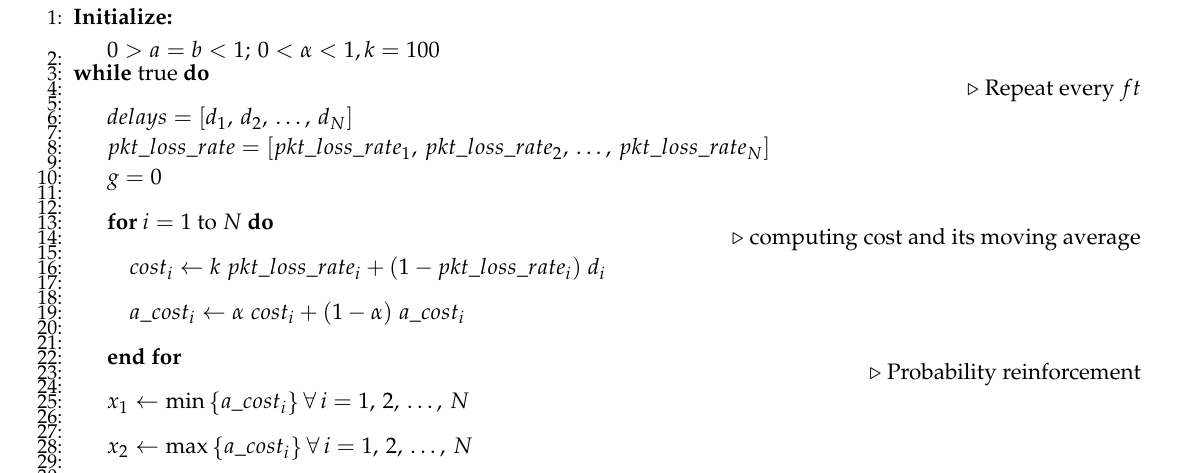
Algorithm 3 Latency and Packet-loss Optimized SLA Feeder Link